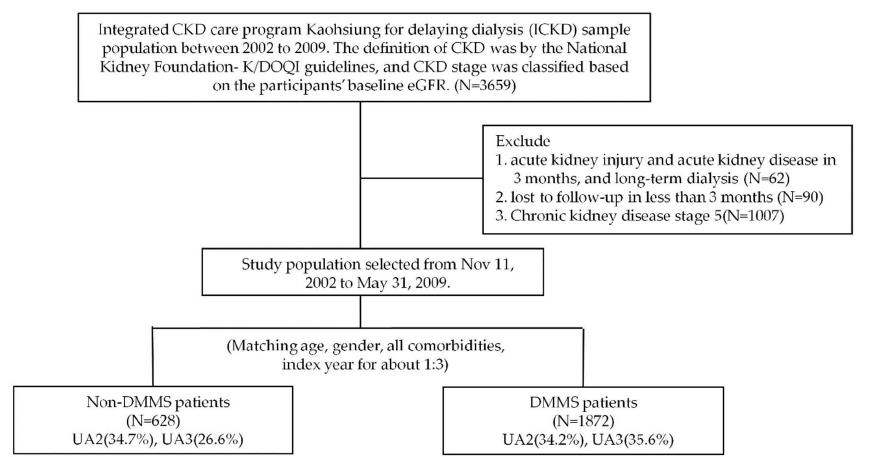
Figure 1. Flow diagram of the study population.